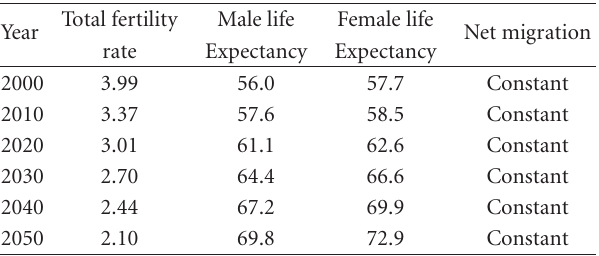
Table 7: Demographic assumptions for Ghana’s population projec- tions: